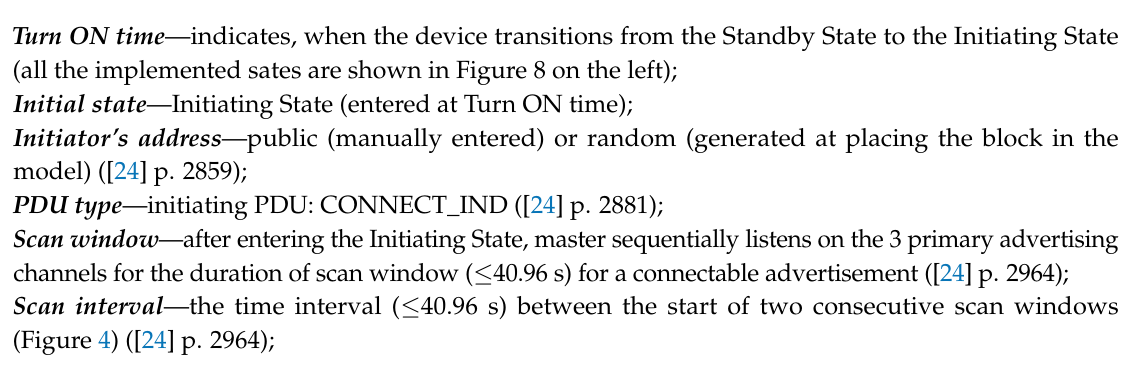
Figure 3. Master’s dialog